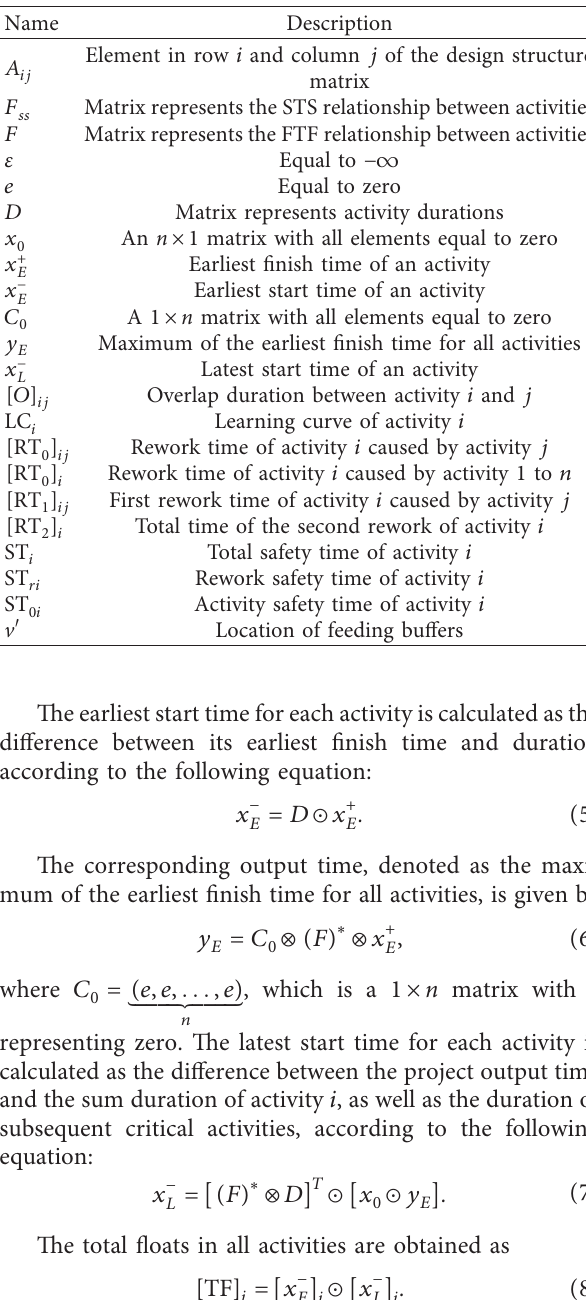
Table 2: Notations in Section